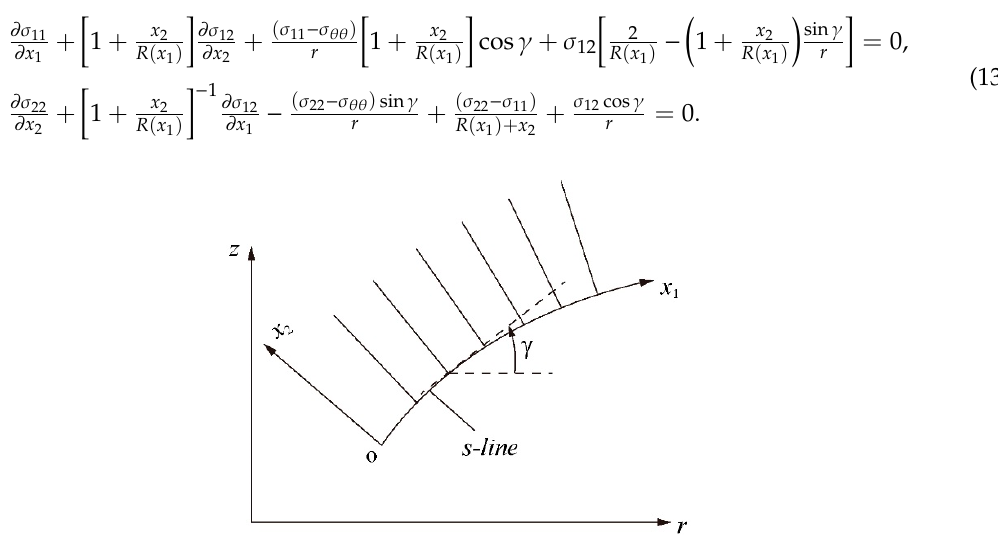
( ) , x x near a given curve (S – line) under axially 1 2